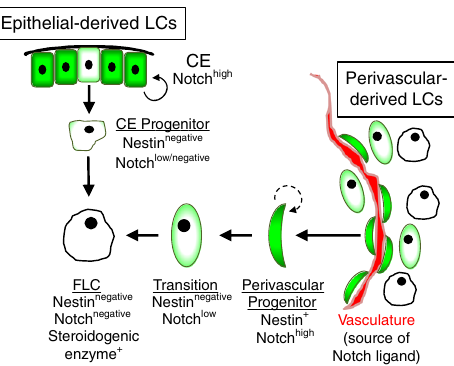
Table 1. Rosa -Tomato and CBF :H2B-Venus expression were detected via endogenous fl uorescence, except for HSD17B3 experiments, in which antigen retrieval weakened tdTomato fl uorescence and necessitated use of anti-RFP (anti- tdTomato) antibody, and Notch2-ICD -Cre lineage-tracing experiments, in which anti-GFP antibody was used to amplify YFP signal. Alexa-488-, Alexa-555-, and Alexa-647-conjugated secondary antibodies (Molecular Probes/Life Technologies/ Thermo Fisher) and Dy-Lite 488 donkey anti-chicken and Cy3 donkey or goat anti-rabbit/rat secondary antibodies (Jackson ImmunoResearch) were used at 1:500. Nuclei were stained with 2 μ g/mL Hoechst 33342 (#H1399, Molecular Probes/Life Technologies/Thermo Fisher), and Hoechst staining is labeled